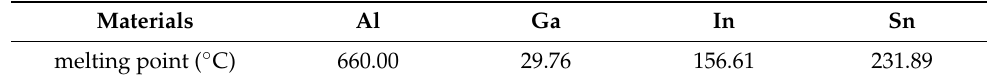
Table 1. The melting points of the metals.